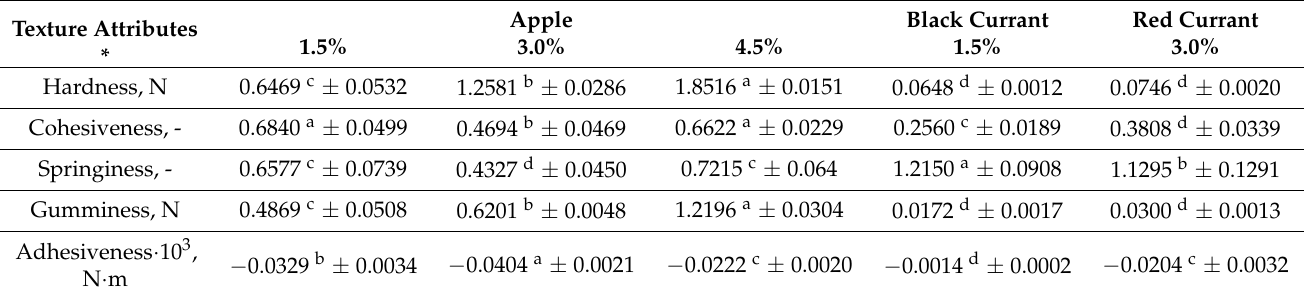
Table 3. Texture